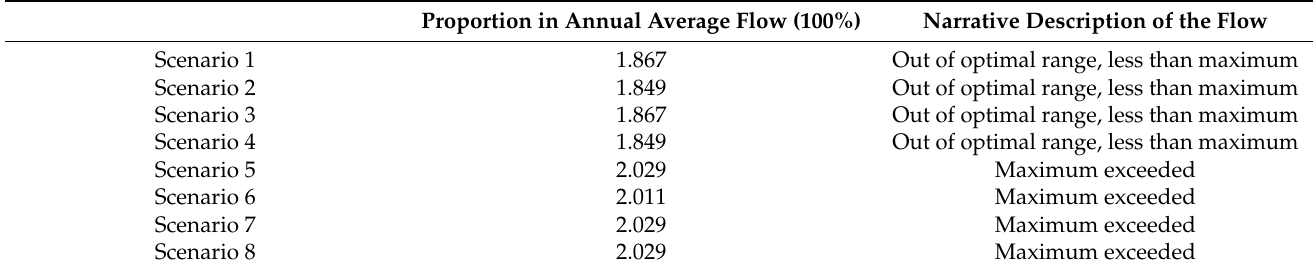
Table 8. Evaluation results of the Tennant method under different water pollution control